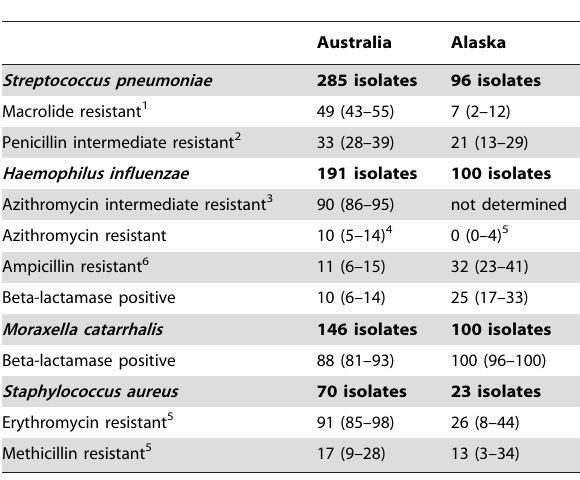
Table 4. Antibiotic resistance as percentage (95% CI) of total isolates in respiratory bacteria from Australian Indigenous and Alaska Native